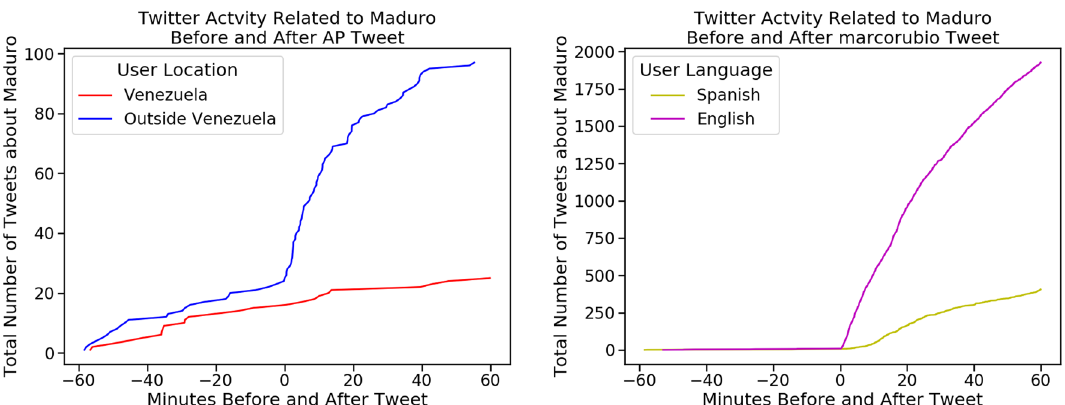
Figure 6. We show examples of Twitter activity within different communities related to Nicolás Maduro following a mention of him by a specific user. As measured from the distance to the line of best fit as shown in Fig. 7, the Associated Press (left) is in the 99.64% percentile for stronger effect outside Venezuela, and Marco Rubio (right) is in the 99.99% percentile for stronger effect in English. We see that after each of their tweets, there is increased spread in each of the communities they influence, which suggests gatekeeping properties in each